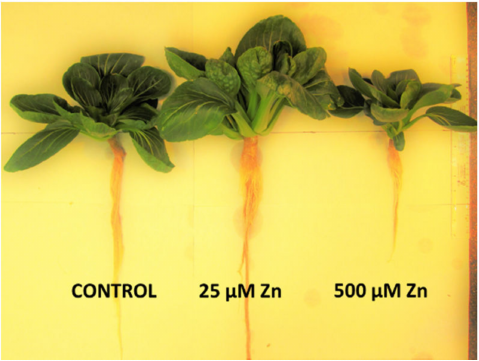
Figure 1. Pak choi plants treated with Zn (0, 25 and 500 µ M).